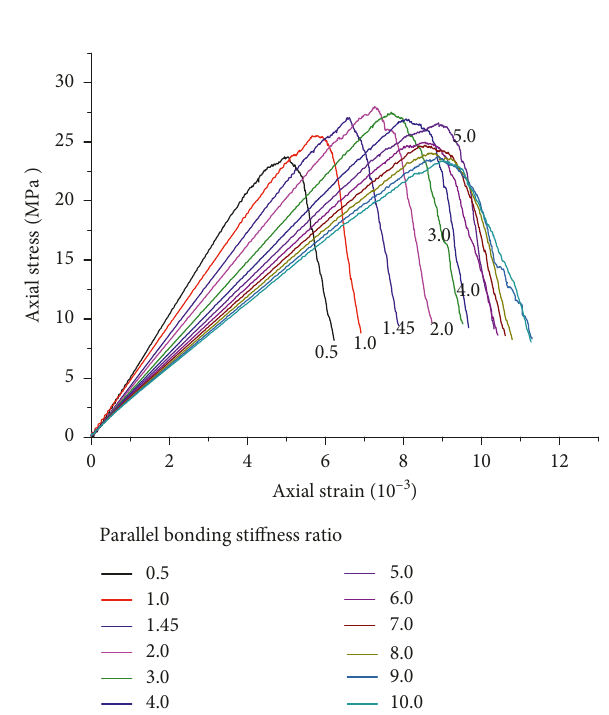
Figure 3: Stress-strain relation for different parallel bonding stiffness